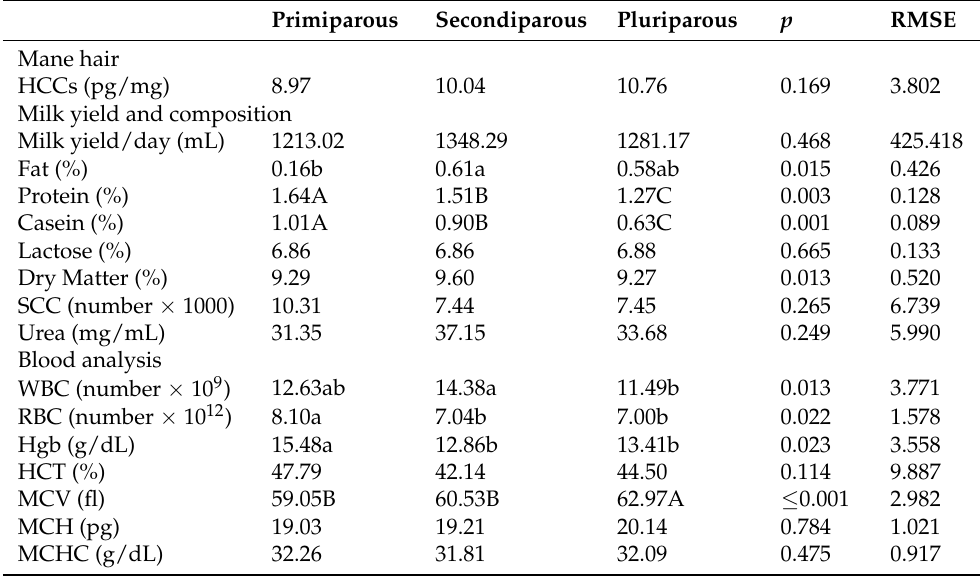
Table 2. Effect of parity on hair cortisol, milk production and blood count. Primiparous Secondiparous